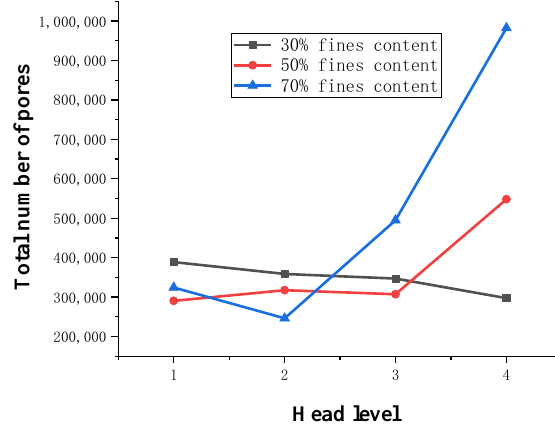
Figure 9. Change in the total pore quantity.